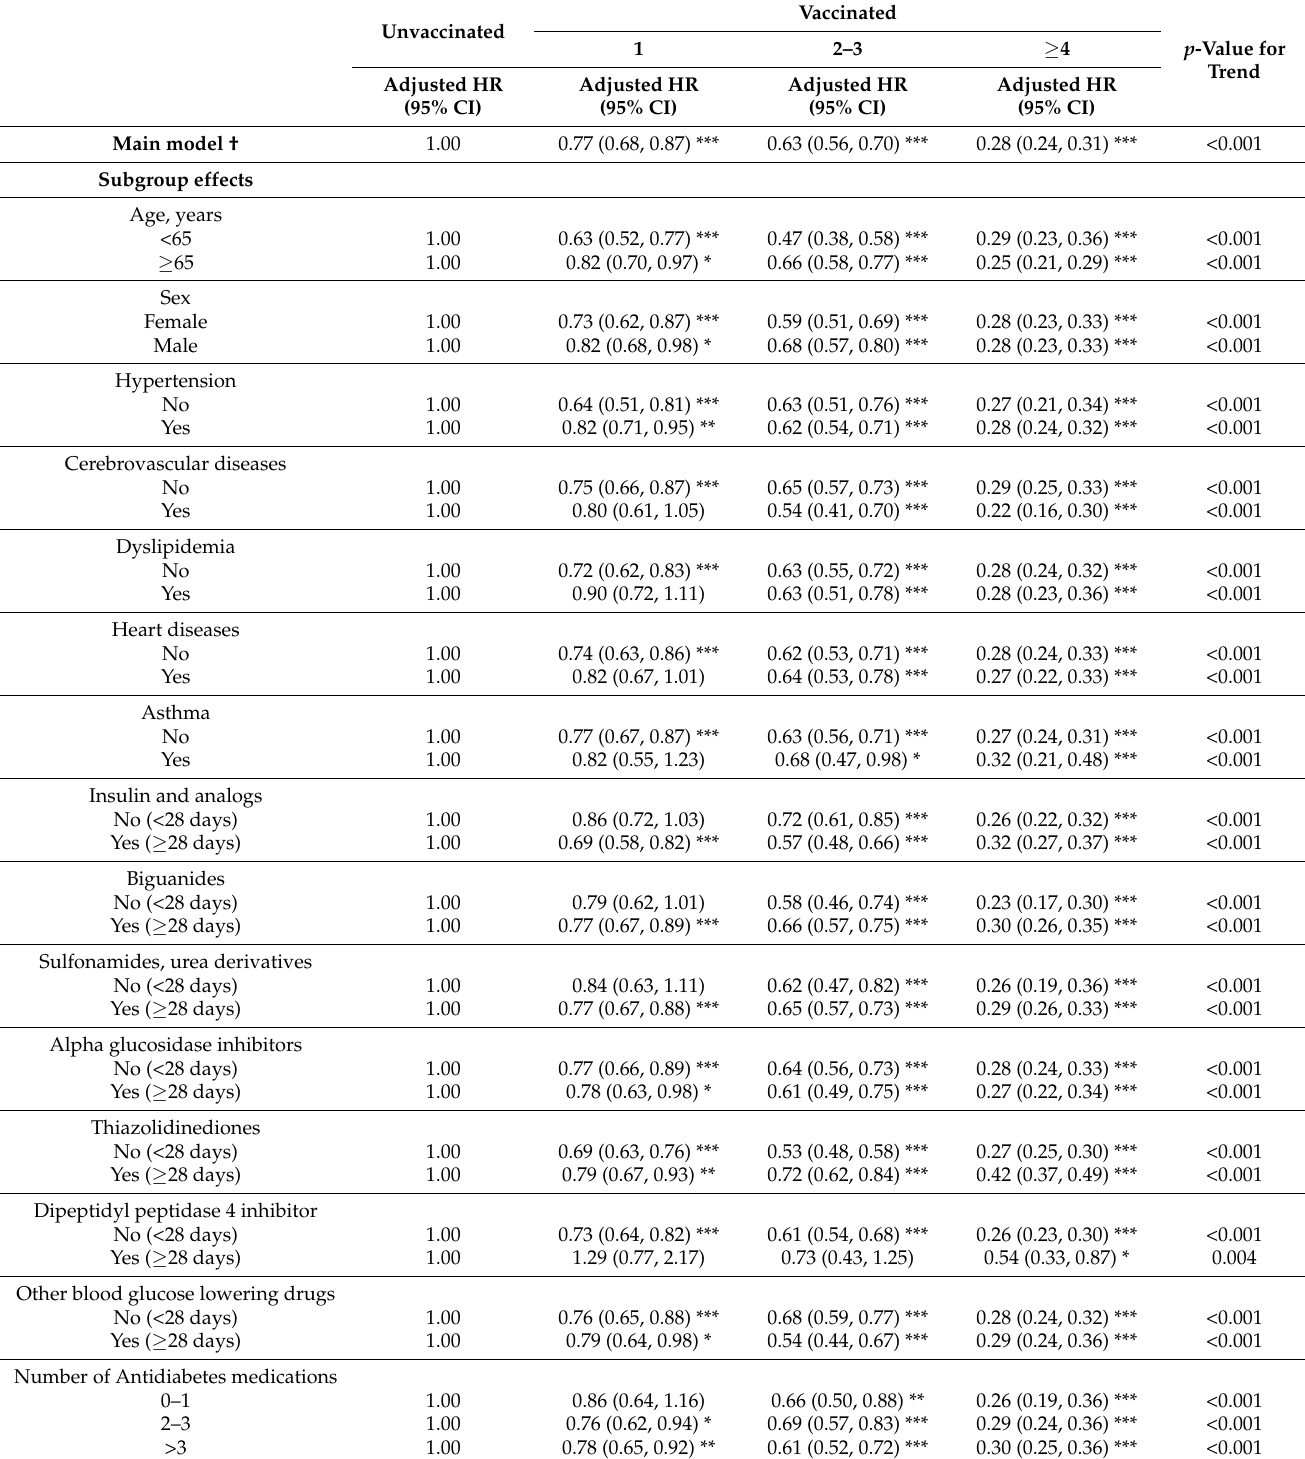
Table 5. Sensitivity Analysis of Adjusted HRs for Vaccination in the Risk Reduction of Dialysis in All